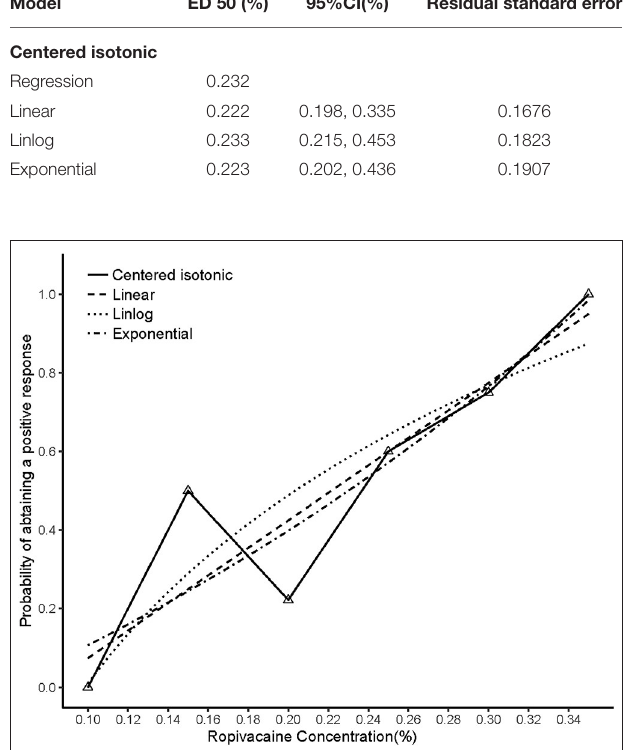
FIGURE 2 | Estimated ropivacaine–Interscalene Brachial Plexus Block relationship for a given dose level and probability of successful block. Median estimators for each model are plotted. The numbers of measurements at each ropivacaine concentration are represented by numbered triangles.